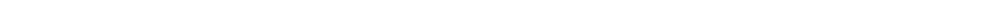
and Red ( n Red , n Black = 100). Not only did their results ( D Black-Green = 0.63 < D Black-Red = 0.89) support their previ- ous findings, but they also demonstrated that Green and Blue completely overlapped, presumably due to their shared co-ancestry, and that together with Cyan ( D Cyan-Green = 0.63 < D Cyan-Red = 1.09) (Fig. 8B,D) they represent an antique color clade. They explained that these color populations only appeared separated due to genetic drift. However, they still retained sufficient cryptic genetic information that PCA can uncover if the cor- rect sampling scheme is used. Further analyses by the other groups contested these findings (Supplementary Fig. S5A-D). Among else, it was argued that Black is a Green–Red admixed group (Supplementary Fig. S5C) and that Black and Cyan were the ancestors of Blue and Green (Supplementary Fig. S5D).